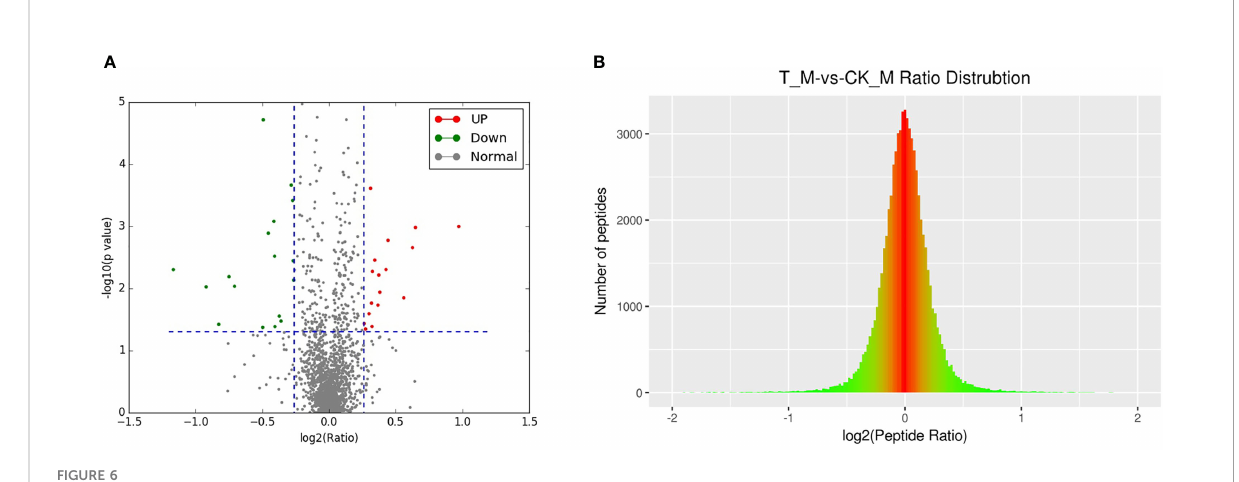
FIGURE 6 DEP distribution ratio of male adult schistosomes.